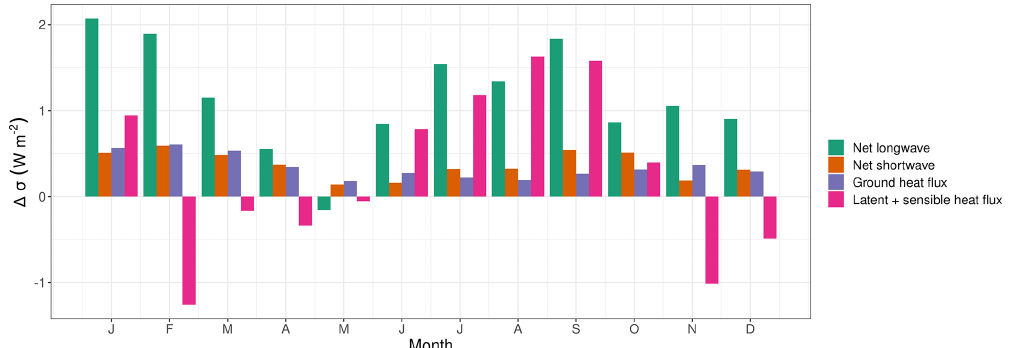
Figure 10. Difference in standard deviation ( (cid:49)σ = σ El Niño – σ La Niña) of different components of the surface energy balance in the Amazon Basin. The latent and sensible heat fluxes are pooled because of their strong negative correlation.